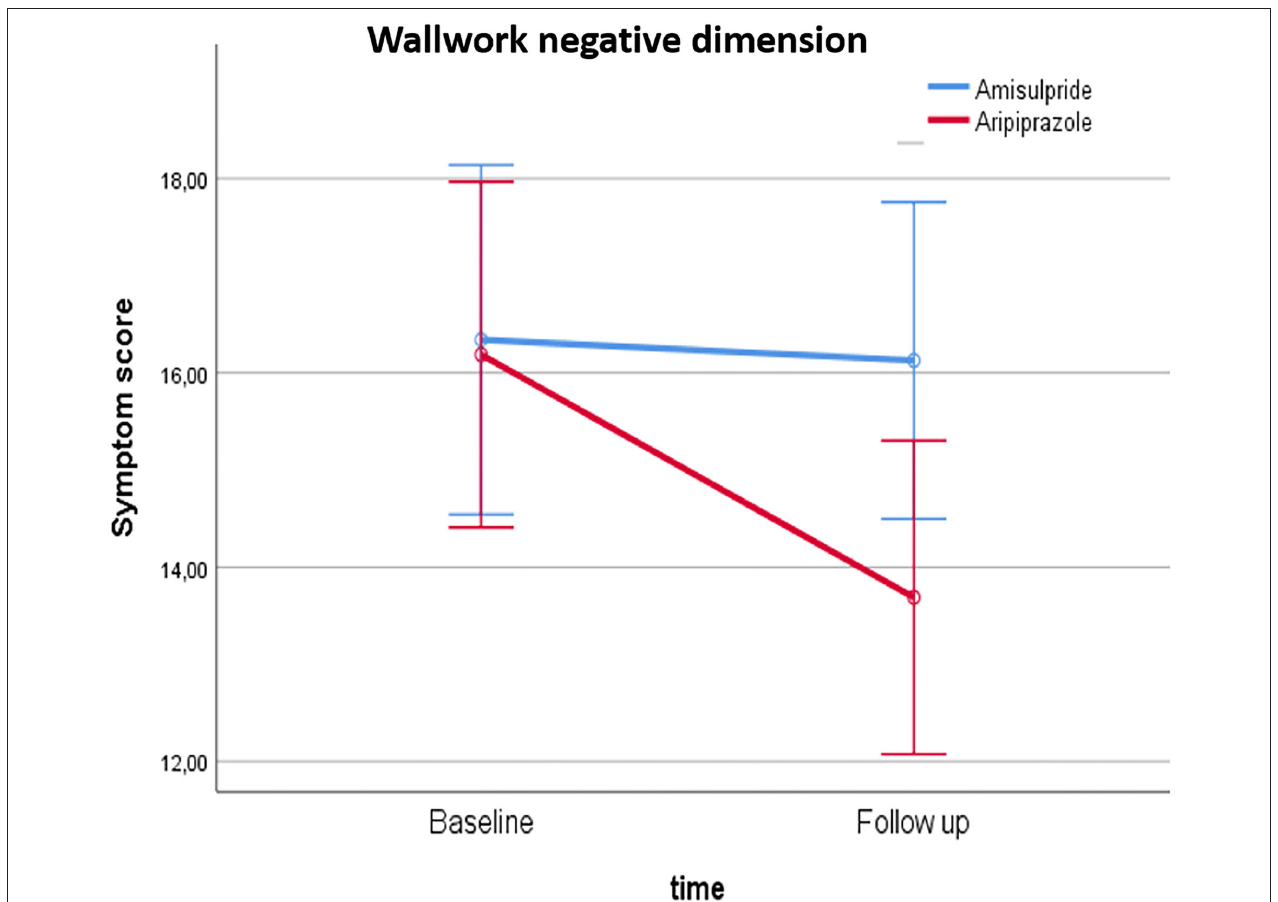
FIGURE 2 | Illustration of the group*time interaction on the Wallwork negative symptom dimension score.